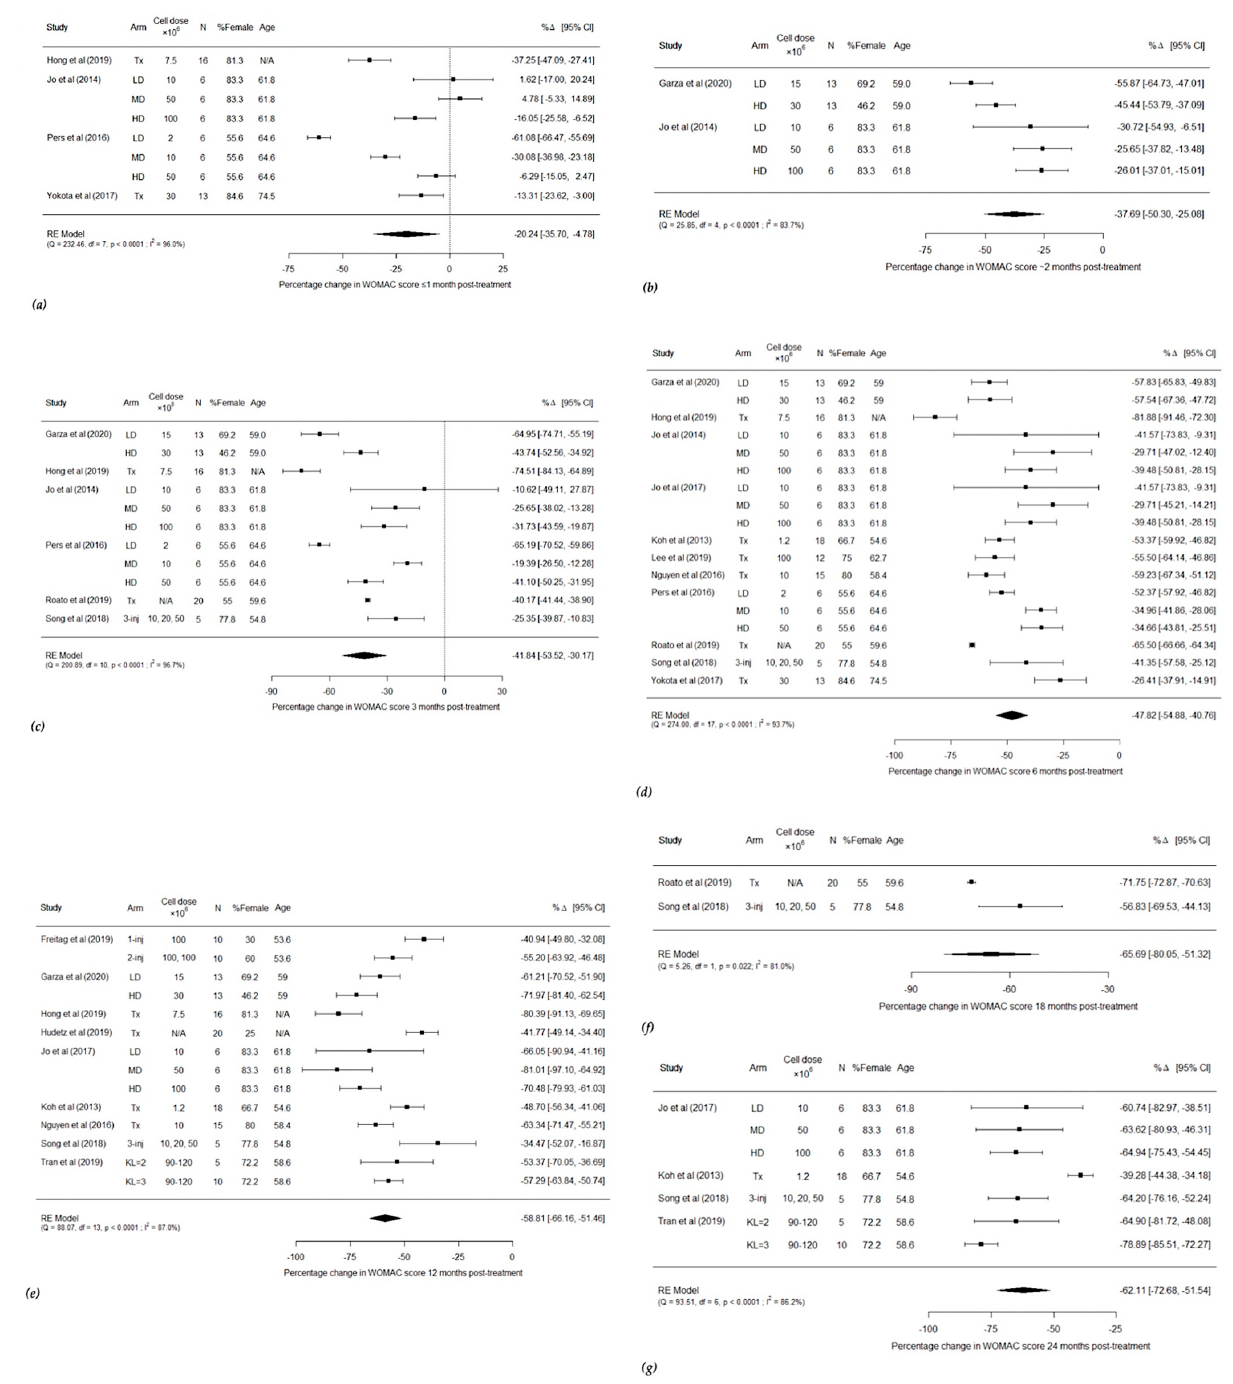
Figure 2. Forest plots showing percentage changes in WOMAC score less than one month after treatment ( a ), approxi- mately two months after treatment ( b ), three months after treatment ( c ), six months after treatment ( d ), twelve months after treatment ( e ), eighteen months after treatment ( f ) and twenty-four months after treatment ( g ) (1-inj = 1 injection, 2-inj = 2 injections, 3-inj = 3 injections, CI = confidence intervals, df = degrees of freedom, HD = high dose, LD = low dose, MD = middle dose, N = number, RE = random effects, Tx = treatment group).